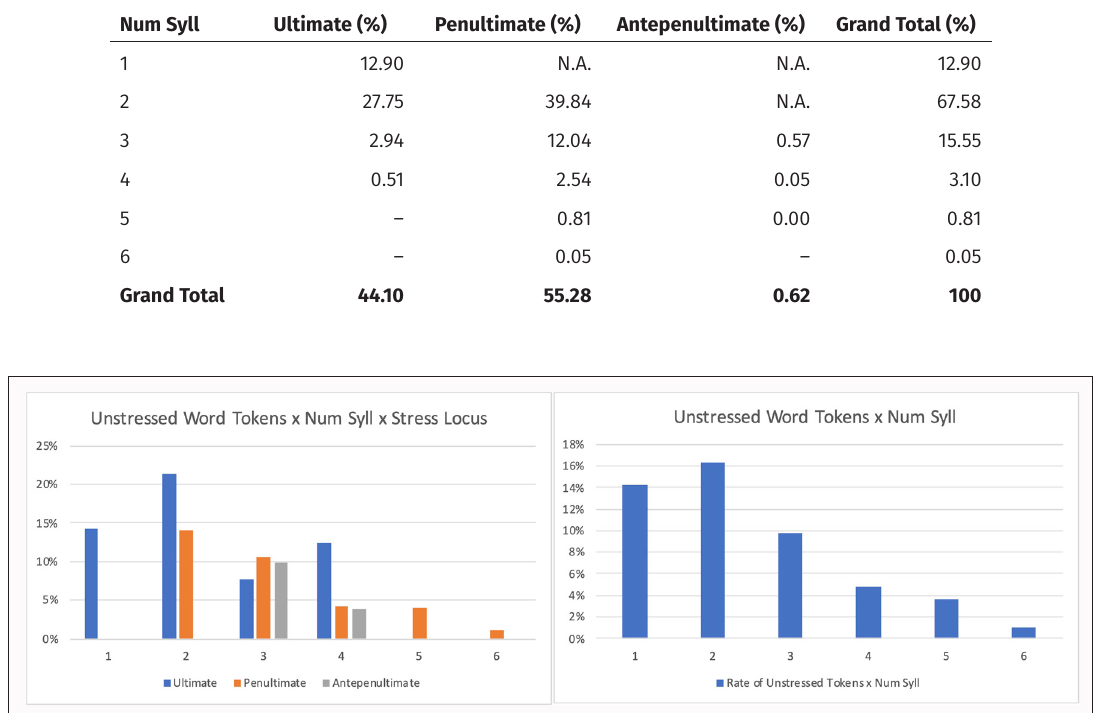
Figure 8: Distribution of Unstressed tokens as a function of the number of syllables and stress